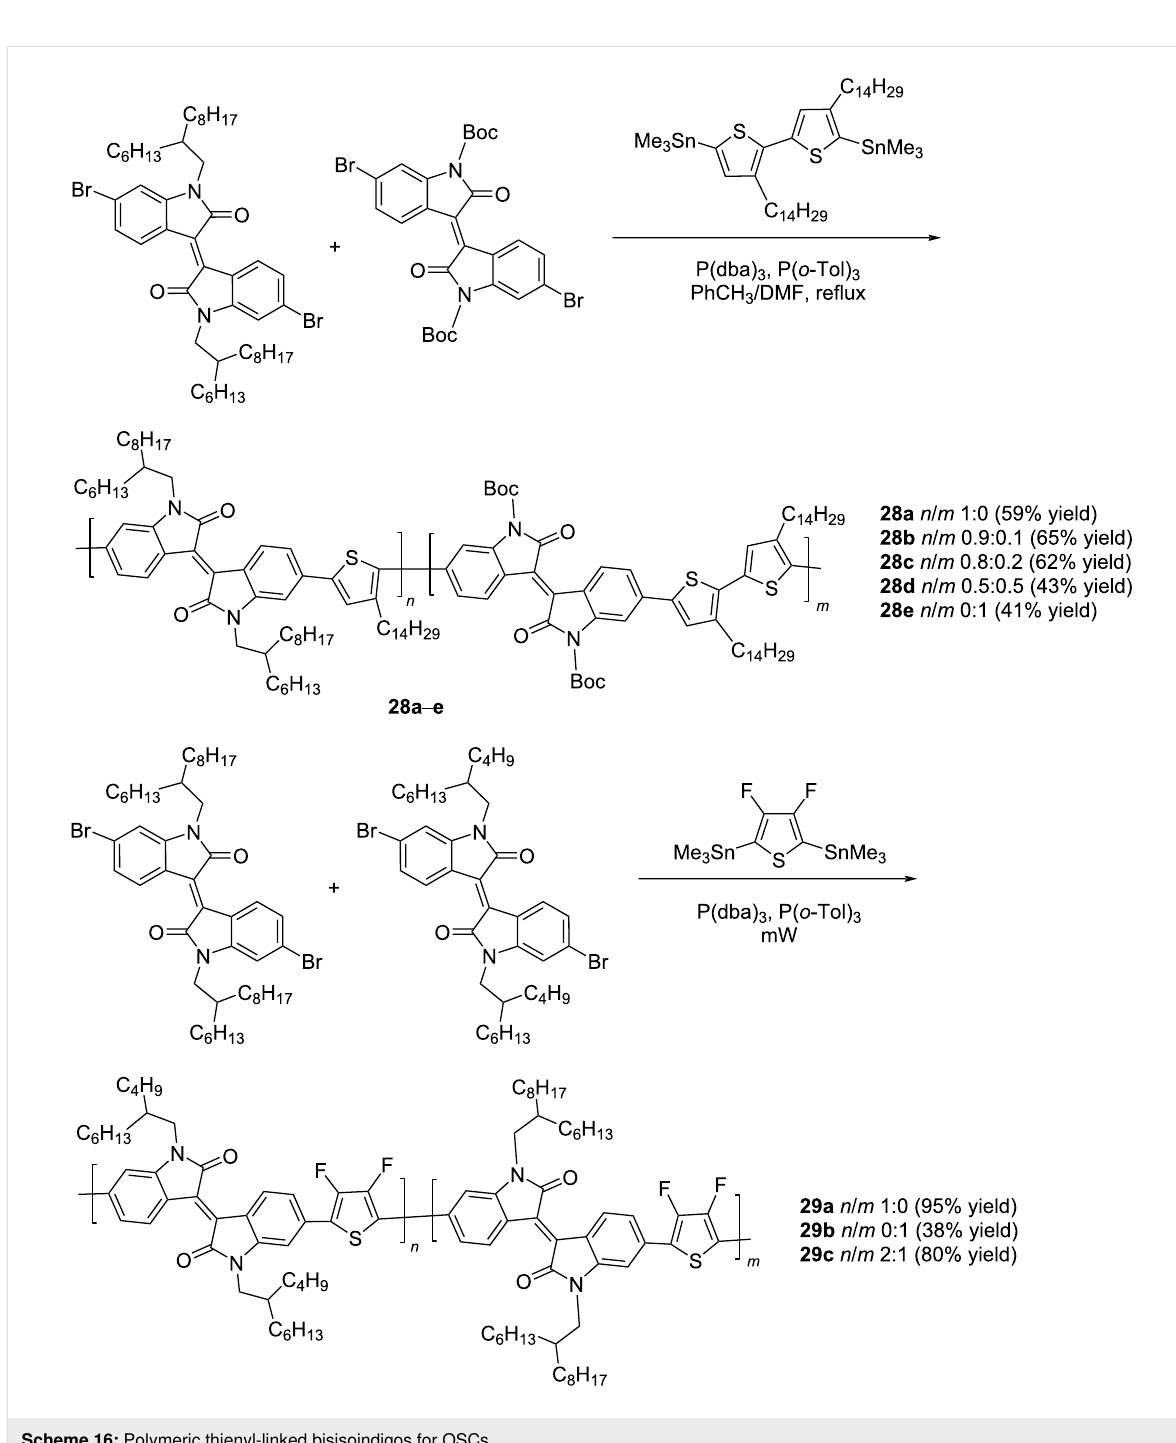
the direction in which isoindigo polymers are used in the design of ternary systems of the OSC active layer. Thus, an OSC consisting of a composite based on two donor polymers (D1 and D2) and an acceptor component PC 71 BM (A) with a D/A weight ratio of 1:4 showed an efficiency of 7.69% with a D1 content of 15% relative to the D2 weight. It should be